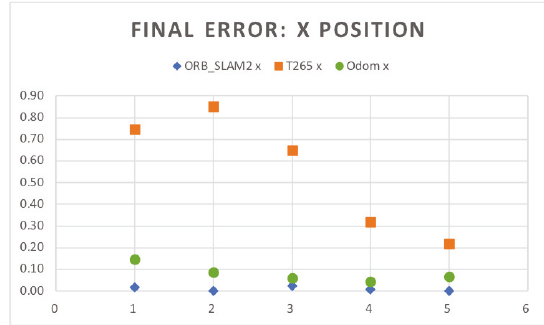
Figure 18. Indoor tests scenario 2. Test 1. Trial 1. Final error X position.